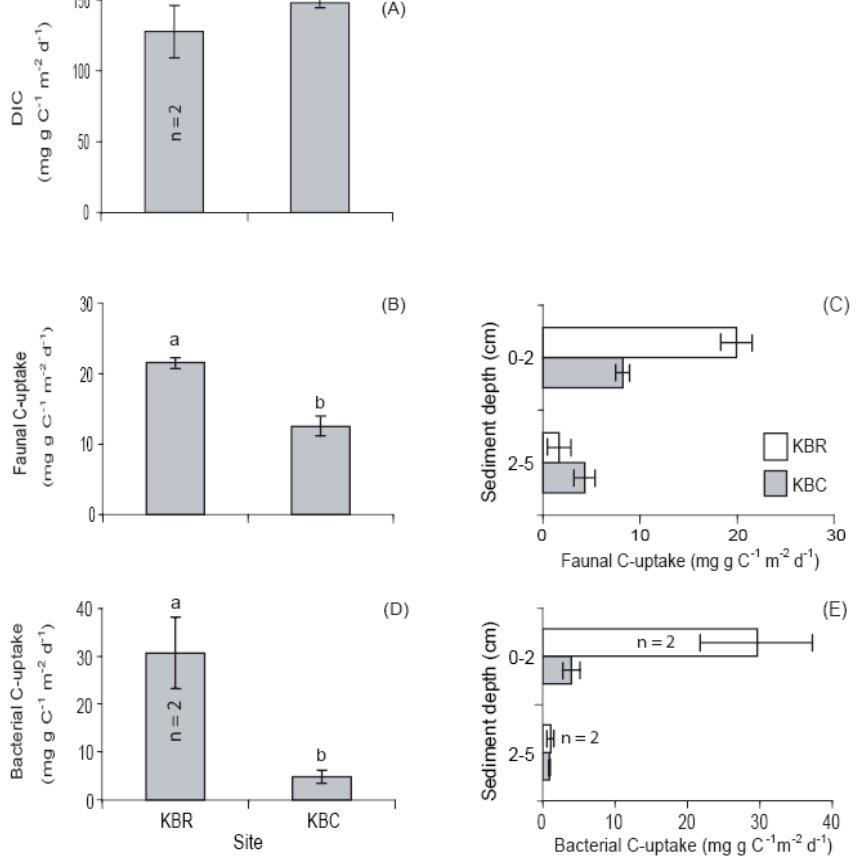
Fig. 8. Total production of DIC (A) from added algal-C in cores collected from all Kaneohe Bay sites. Total and vertical distribution of macrofauna C-uptake ( B and C , respectively) and bacterial C-uptake ( D and E , respectively) in cores from all Kaneohe Bay sites are shown. Significant differences ( P < 0.05) in parameters between sites are designated by different letters. Error bars denote ± 1SE ( n = 3) unless n = 2, where error bars denote ± range of two samples because of insufficient sample for analysis from a 3rd replicate